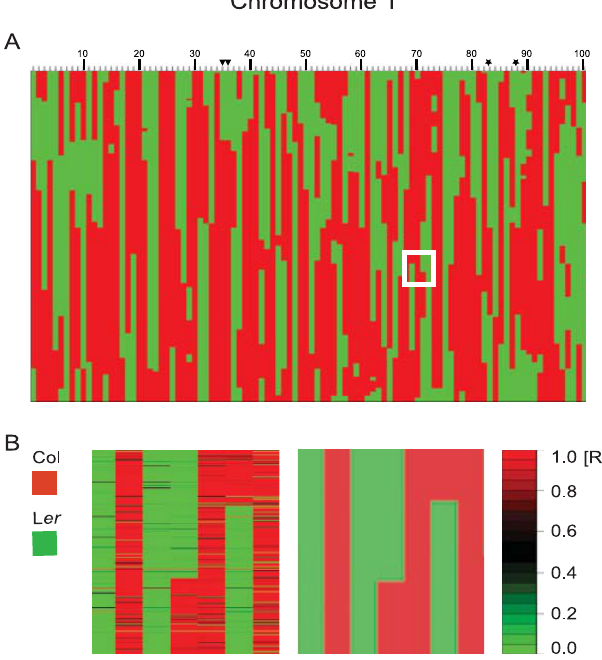
Figure 2. Graphical Genotype of Chromosome 1 for All Col/L er RILs (A) The 100 lines are arranged in numerical order according their CS number. Each column represents a single line from the Col/L er RIL population. The 3,798 SFP markers for Chromosome 1 are plotted vertically. Red areas indicate stretches of Col SFP alleles, green areas indicate L er genotype. The duplicated lines CS1935 and CS1936 are marked with black triangles and the duplicated lines CS1983 and CS1988 are marked with black stars. (B) A magnified view of the region marked with a white square in (A). Left: Genotyping results based on the computed ratio (color legend to the right; R ¼ ratio) before SFP-calling and breakpoint determination. The complete results for all 100 RILs for Chromosome 1 are shown in Figure S3. Black lines indicate features where parental allele could not be determined. Red lines in stretches of green and green lines in stretches of red indicate possible genotyping errors, recombination events that were not deemed significant or gene conversion events. Right: Genotyping results after SFP-calling and breakpoint prediction with structural change analysis. DOI: